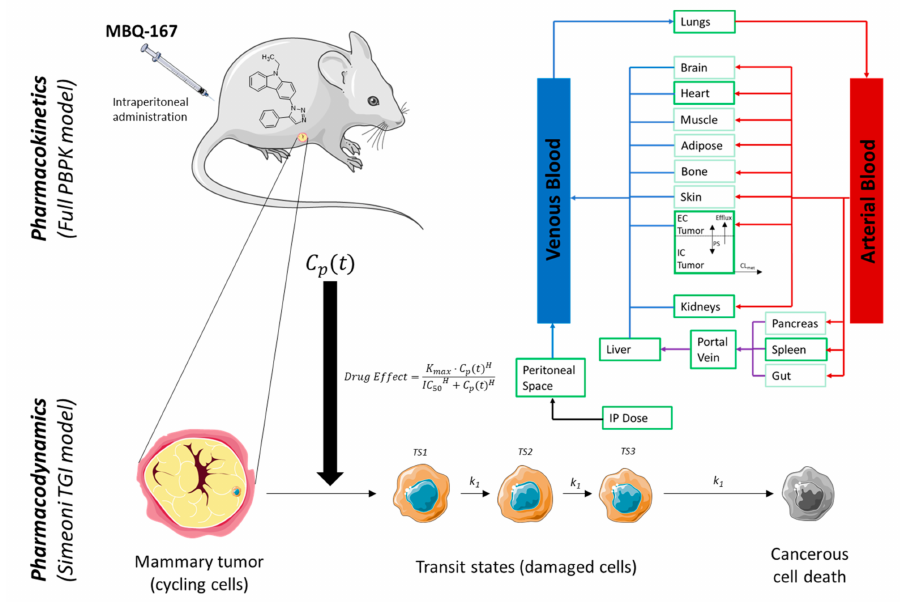
Figure 1. MBQ-167 PBPK-PD model structure. Light green compartments were included in the full PBPK distribution model but not evaluated in the present work. EC: extracellular water. IC: intracellular water. E ffl ux: clearance of the e ffl ux transporter. PS : passive permeability clearance between intra- and extracellular water. CL met : metabolic clearance at the tumor tissue. C p(t): plasma concentration over time. K max : maximum inhibition. IC 50 : concentration associated with K max / 2. H: Hill coe ffi cient.